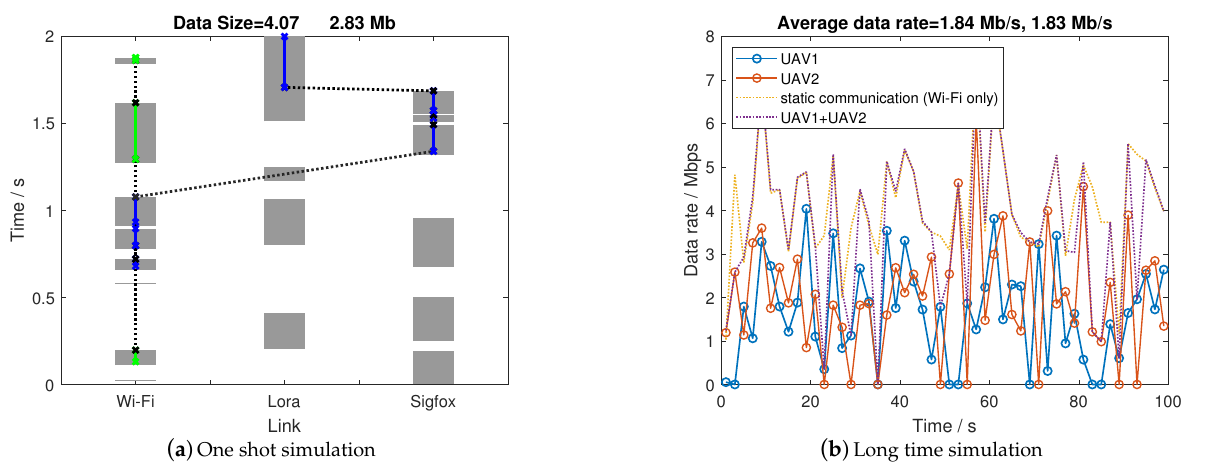
Figure 8. Communication performance with two UAVs